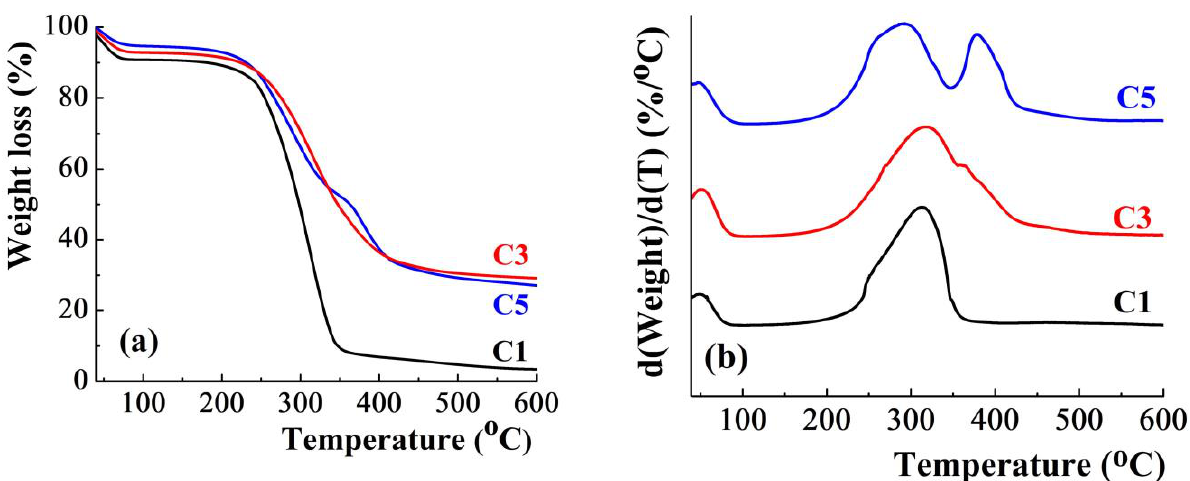
Figure 7. TGA ( a ) and DTG ( b ) curves of CS/PEG films with various amounts of Lap.